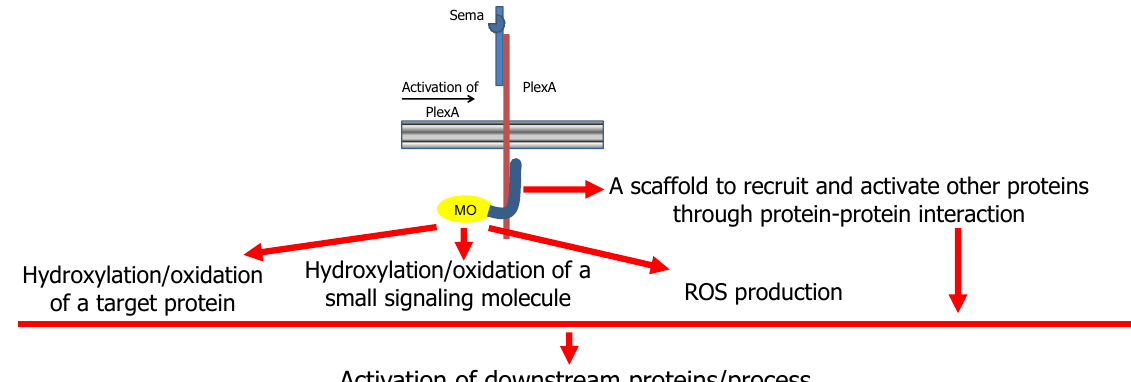
Figure 2. Schematic representation of the proposed functions of MICAL. The scheme is based on